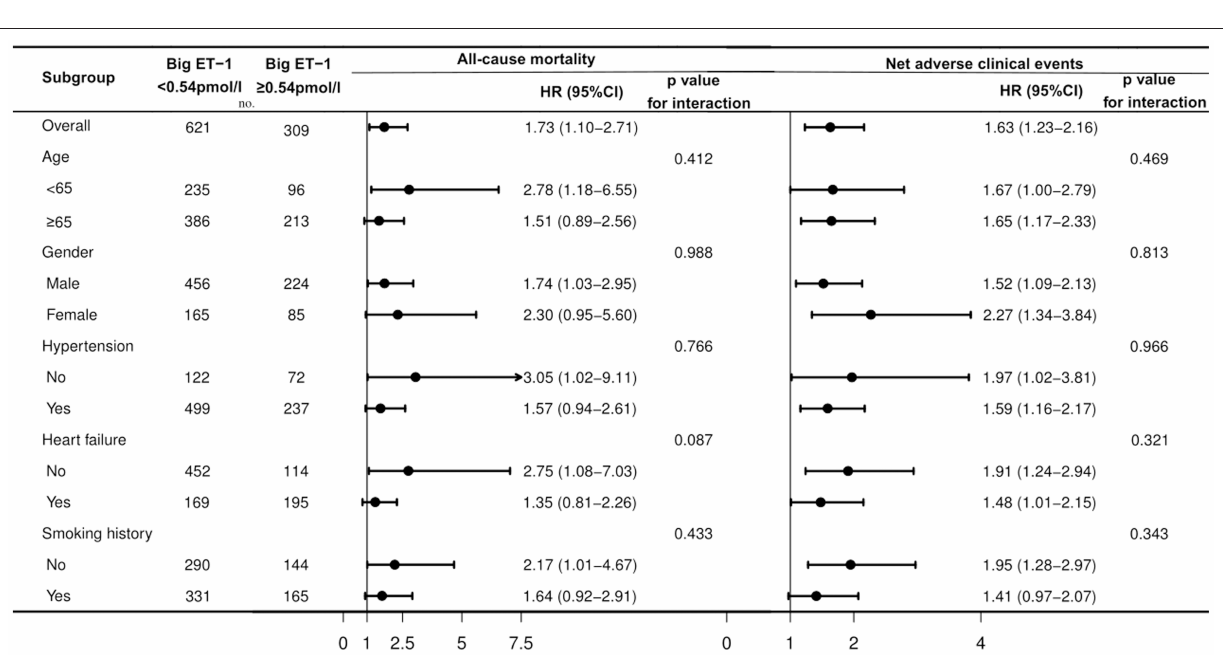
FIGURE 2 | Subgroup analysis for associations between big ET-1 ≥ 0.54 pmol/l and the primary endpoints in patients with AF and ACS or undergoing PCI. AF, atrial fibrillation; ACS, acute coronary syndrome; PCI, percutaneous coronary interventions; big ET-1, big endothelin-1; HR, hazard ratio; CI, confidence